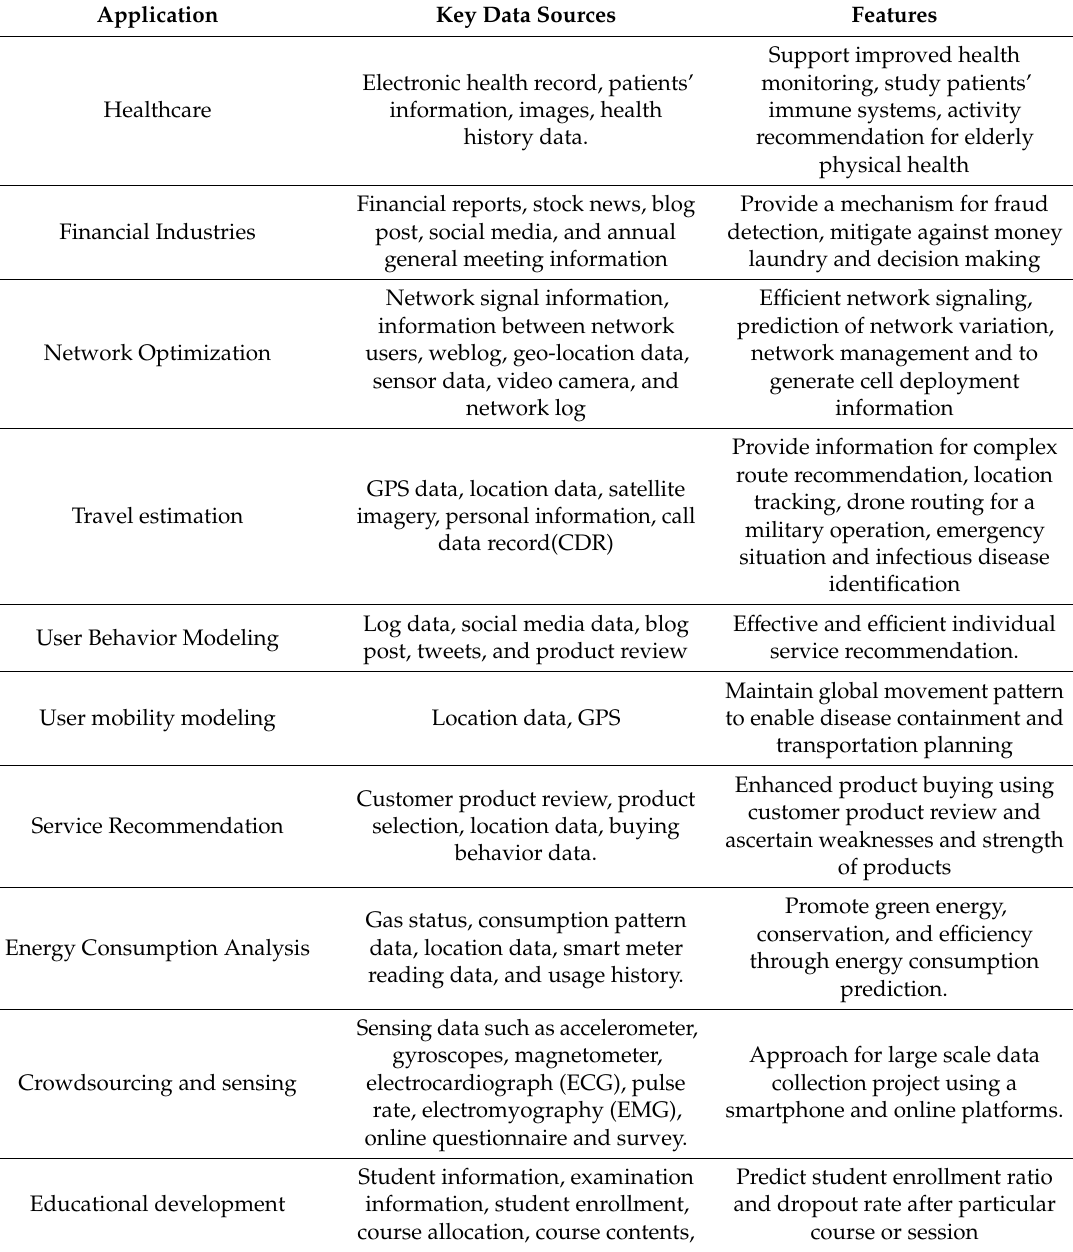
Table 3. Applications and key data sources for big data and business